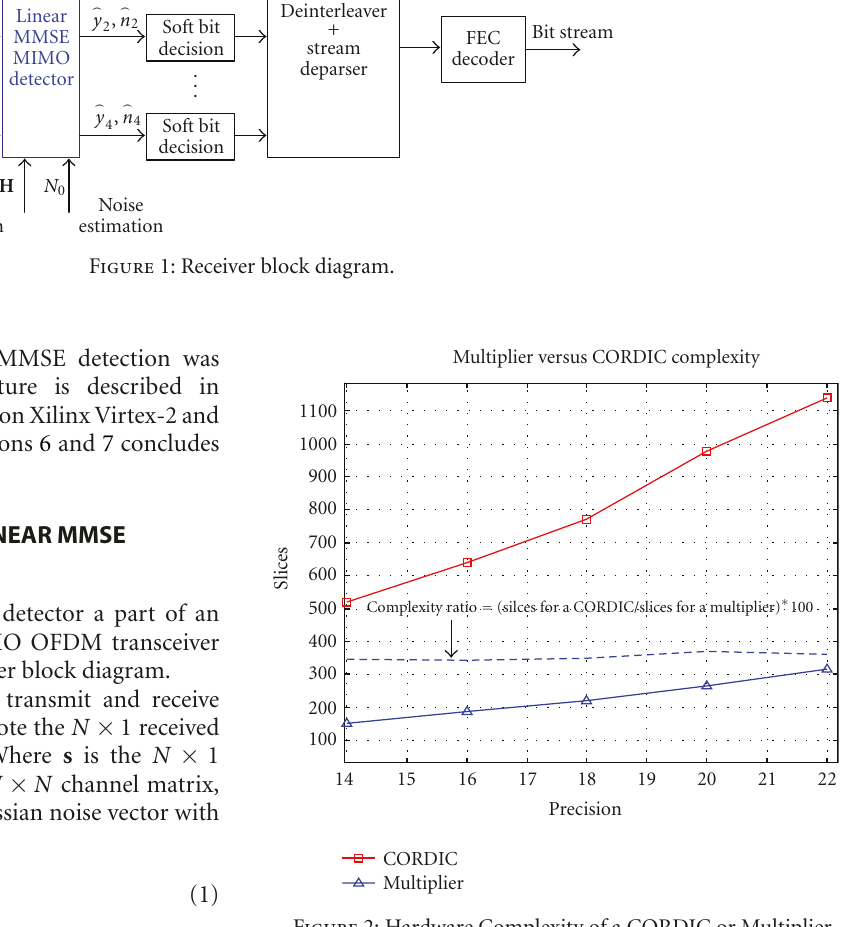
Figure 2: Hardware Complexity of a CORDIC or